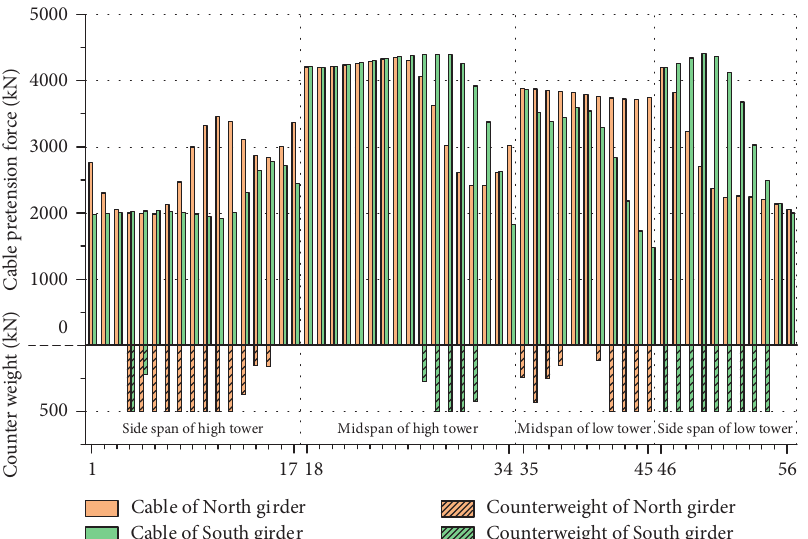
Figure 12: Design variables of girders (cable forces and